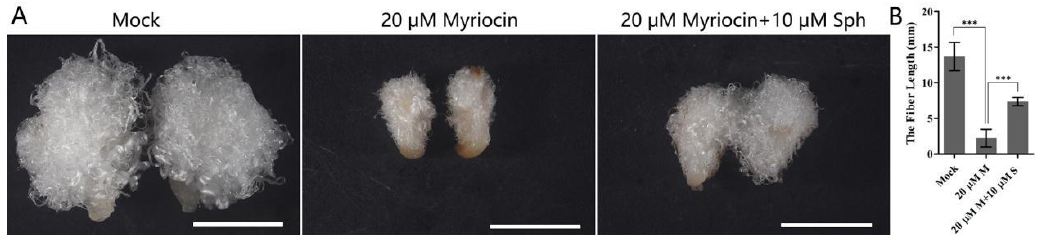
Figure 7. Exogenous application of myriocin and Sph to an in vitro ovule culture system. ( A ) Cotton ovules were collected at 2 DPA and were cultured for 10 days in the in vitro ovule culture system. BT medium adjusted with the amount of DMSO equivalent to that used to dissolve myriocin and sphingosine was used as the mock system. Bar = 5 mm. ( B ) The length of fibers cultured for 10 days in the ovule culture system. Here, 20 μM M represents the 20 μM myriocin treatment, and 20 μM M + 10 μM S represents the 20 μM myriocin and 10 μM sphingosine treatment. Error bars represent the SD for at least 10 seeds. Triple asterisks indicate statistically significant differences between various treatments, as deter- mined by Student’s t-test (*** p < 0.001).